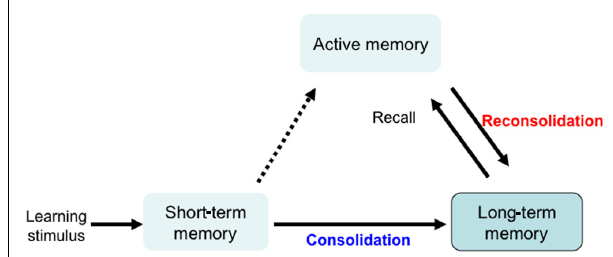
FIGURE 1 | Mechanism for memory formation and maintenance. Learning stimulation leads to short-term memory, which lasts a few hours and is converted to long-term memory through a process of consolidation. Active memory is formed by recalling and updating long-term memory.This updated memory becomes long-term memory through a process of memory reconsolidation. Reconsolidation is a protein synthesis-dependent process that is required for updating the reactivated memory and for maintaining long-term memory.